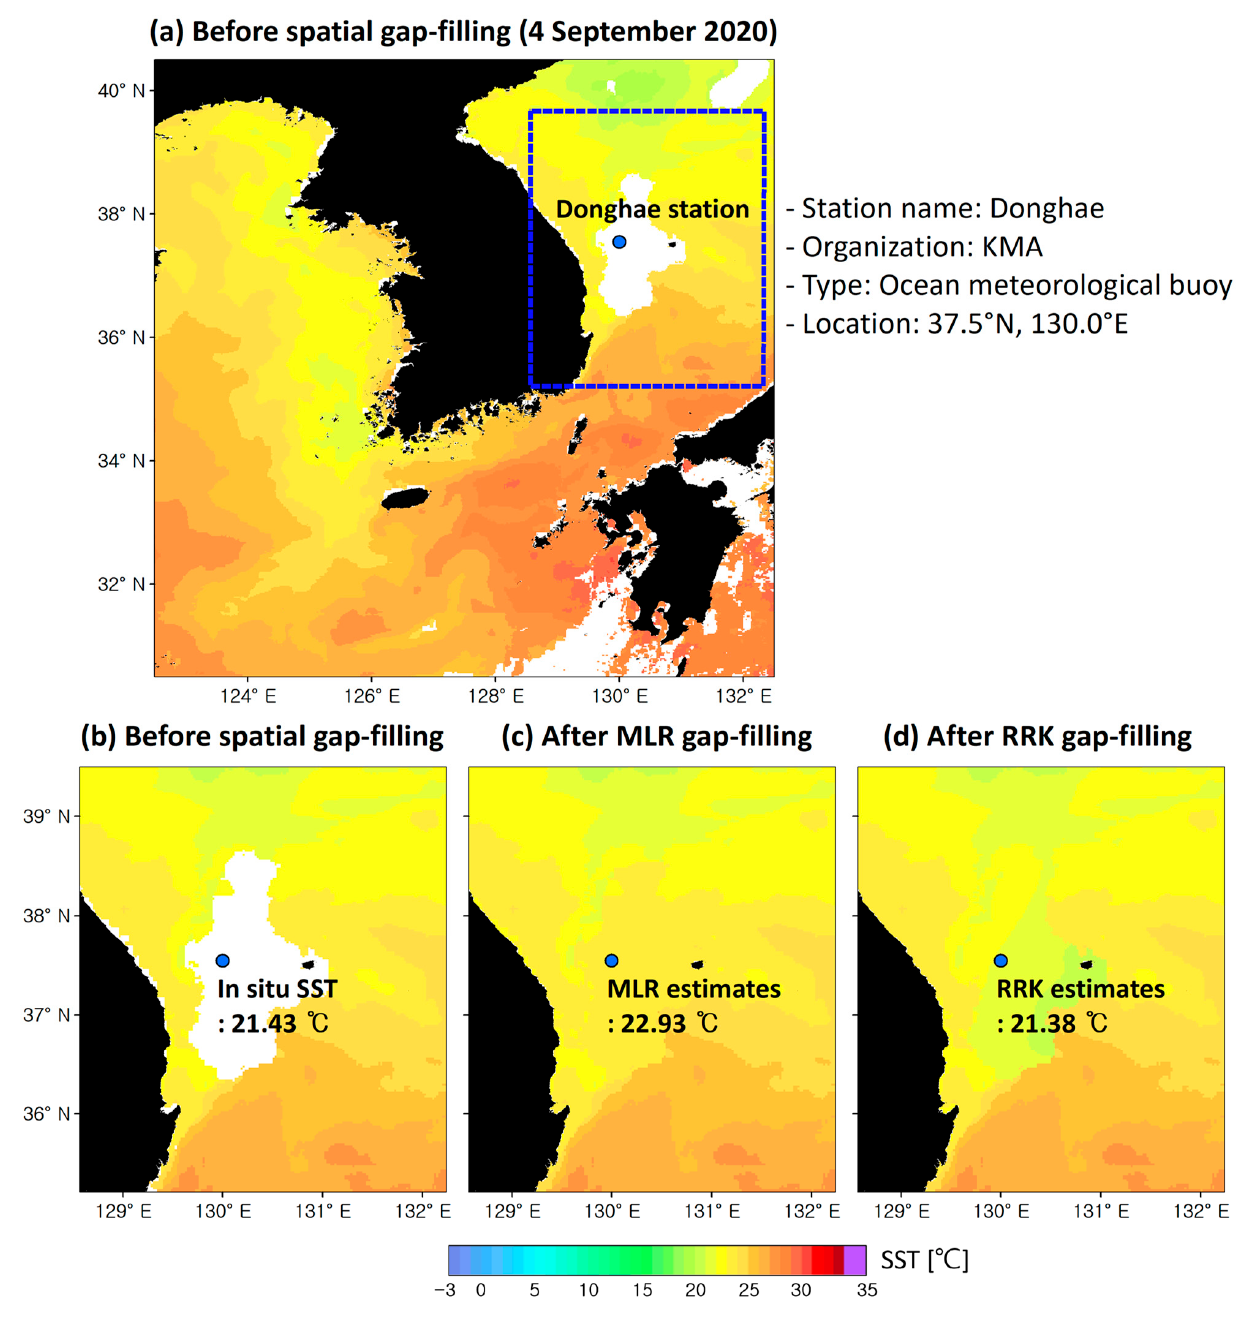
Figure 19. GK2A SST maps before and after the MLR and RRK gap-filling around the Donghae station on 4 September 2020. ( a ) The location of the Donghae station in the study area. ( b ) denote images before spatial gap-filling. ( c ) gap-free SST after MLR, and ( d ) gap-free SST after RRK. The RRK result was stable under the influence of typhoons because it can cope with the abrupt changes in marine meteorology.